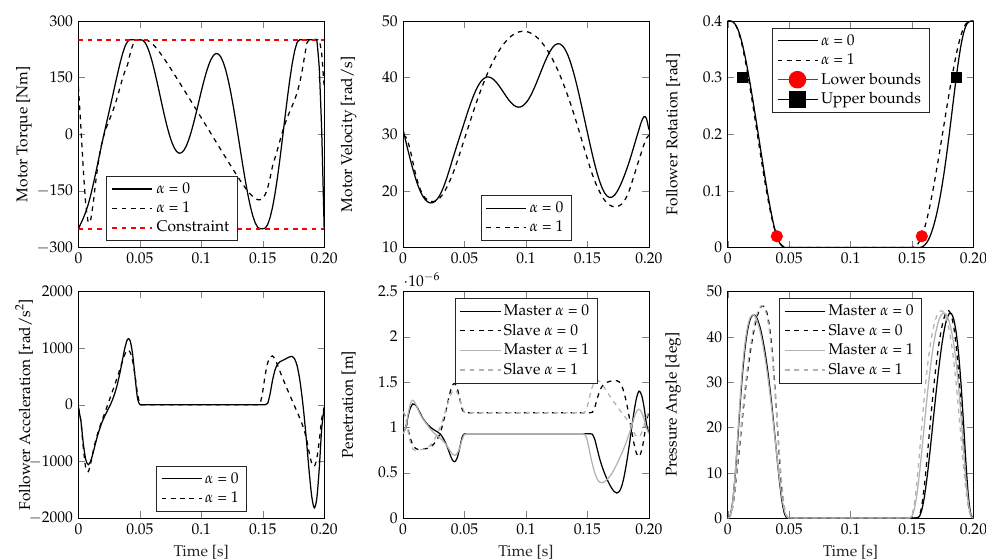
Figure 11. OCP results: minimization of energy consumption ( α = 0) and cam-follower accelerations ( α = 1).